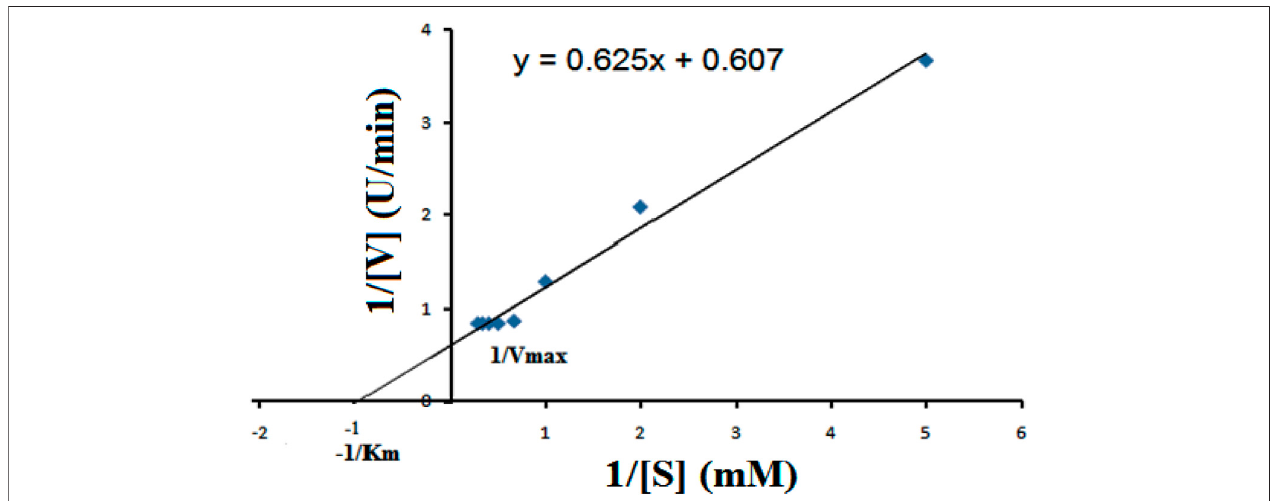
FIGURE 6 | Lineweaver – Burk plot for the determination of Vmax and Km values of the partially puri fi ed cellulase from B. subtilus, at optimum conditions (60 ° C, pH 5.0), in the presence of different concentrations of CMC as the substrate.